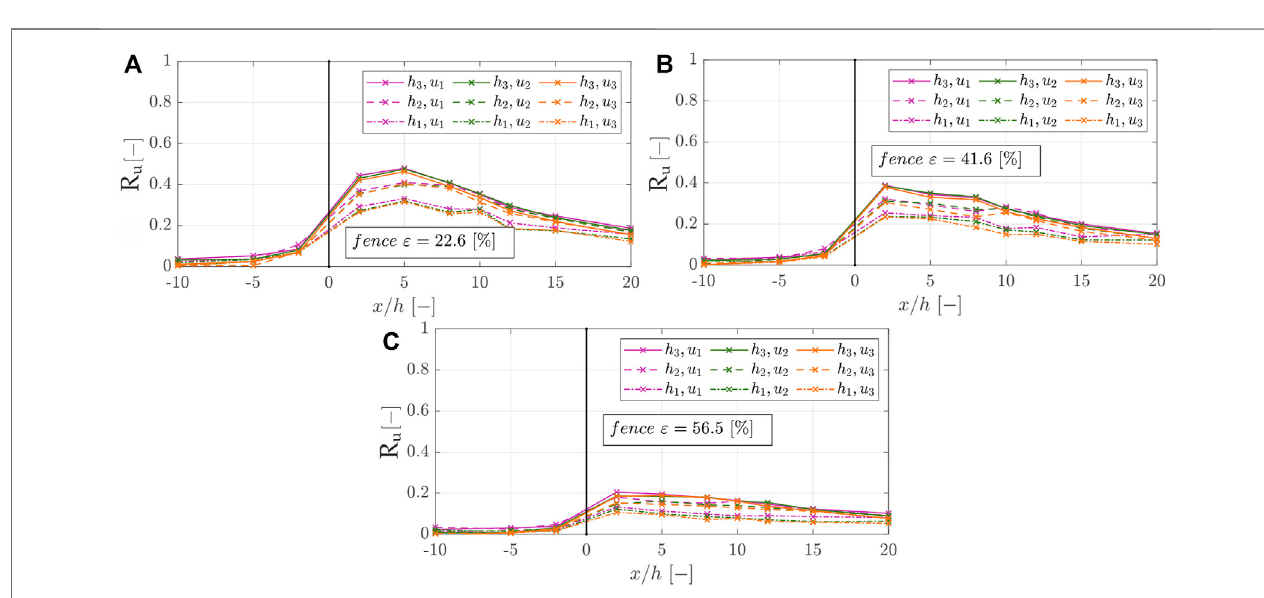
Frontiers in Built Environment |